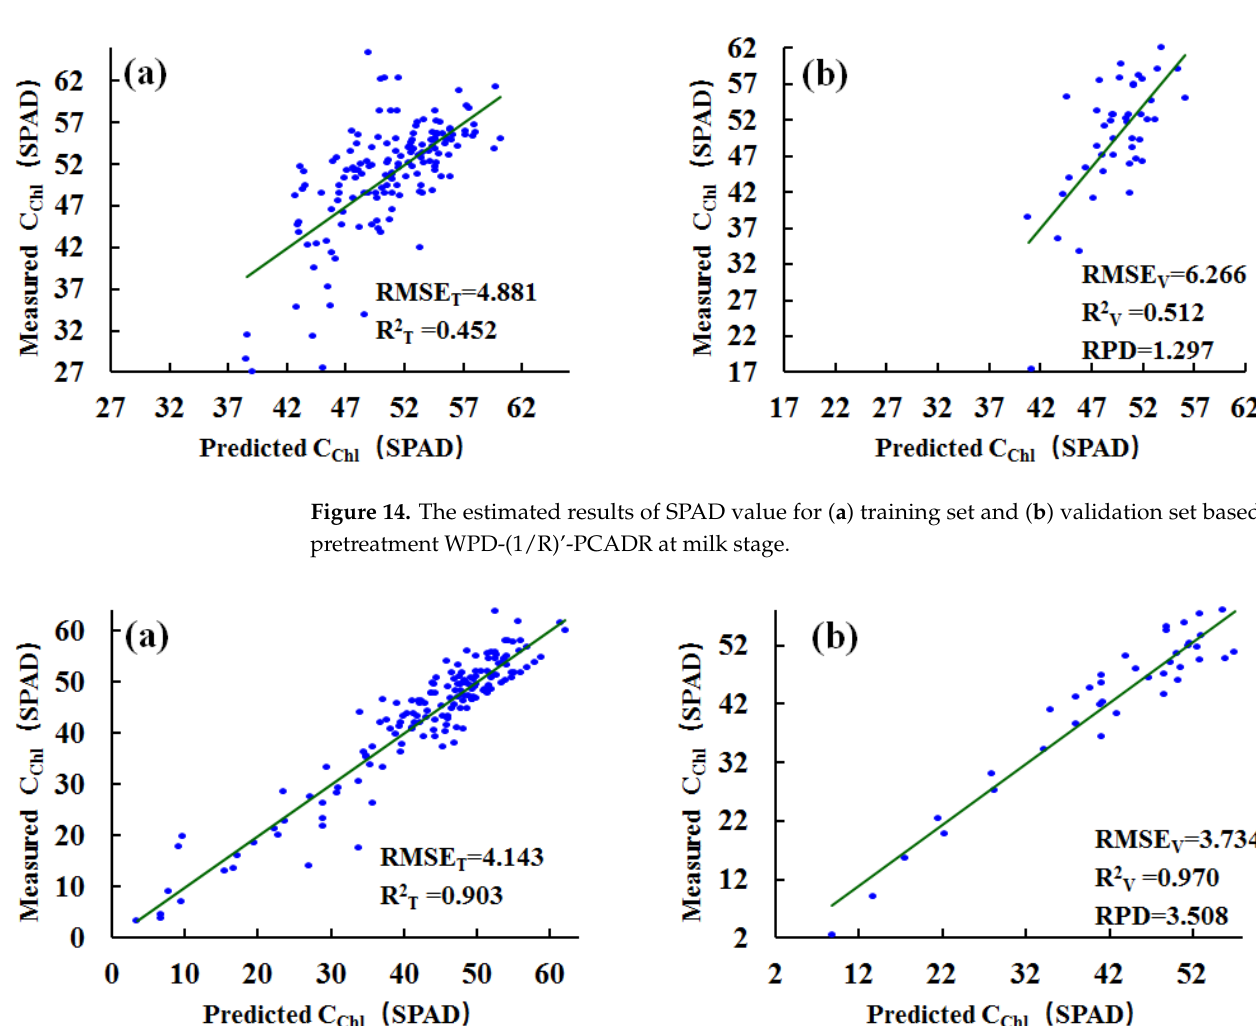
Figure 15. The estimated results of SPAD value for ( a ) training set and ( b ) validation set based on pretreatment WPD-R’-PCADR at mature stage.